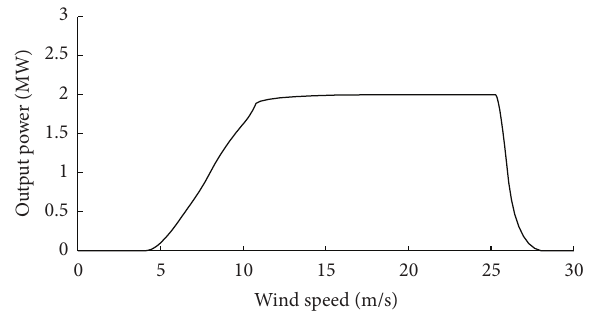
Figure 2: Output power characteristics of the wind generator.